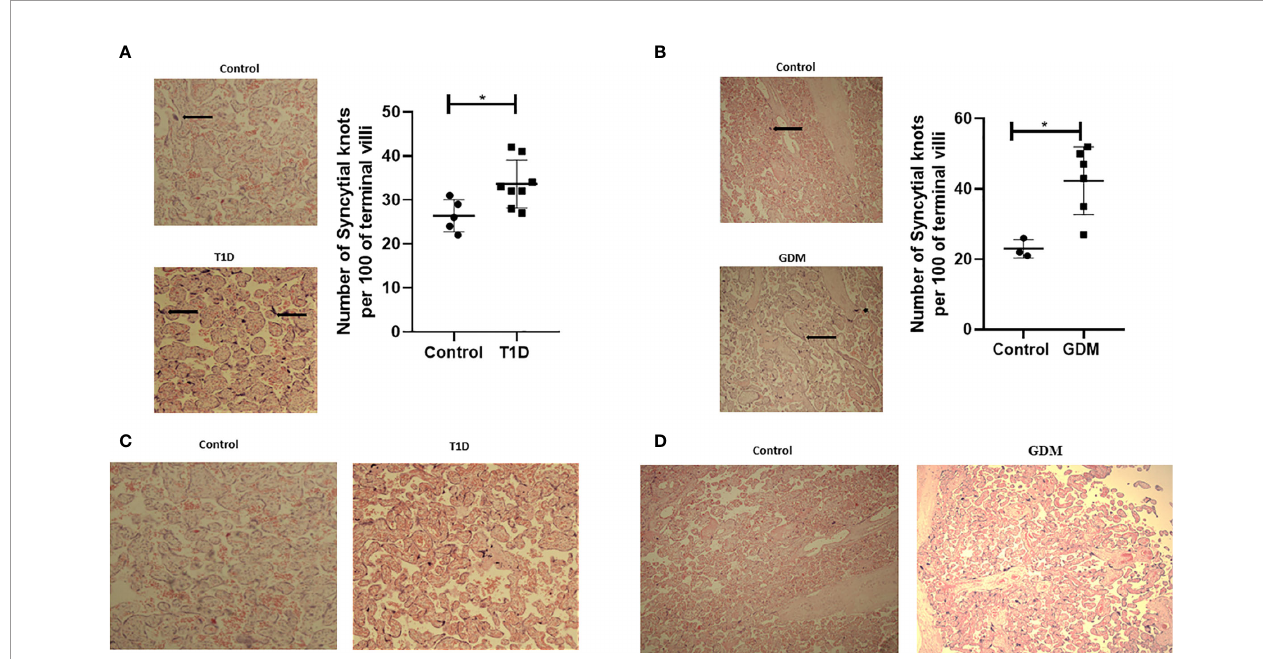
FIGURE 1 | Signs of placenta hypoxia is evident concomitantly with increased levels of villous vascularity in diabetes. Paraf fi n-embedded placental sections were stained with H&E with 2 separate fi elds/section imaged at 4x magni fi cation. The number of syncytial knots which are aggregates of syncytial nuclei at the surface of terminal villi (black spots indicated by arrows) are increased in placental samples from women with T1D (A) or GDM (B) compared to healthy controls (T1D, n=8, GDM, n=6 unpaired t-test, *<0.05). Villous vascularity (indicated by increased red staining) is abundant in T1D (C) and GDM (D) compared to healthy